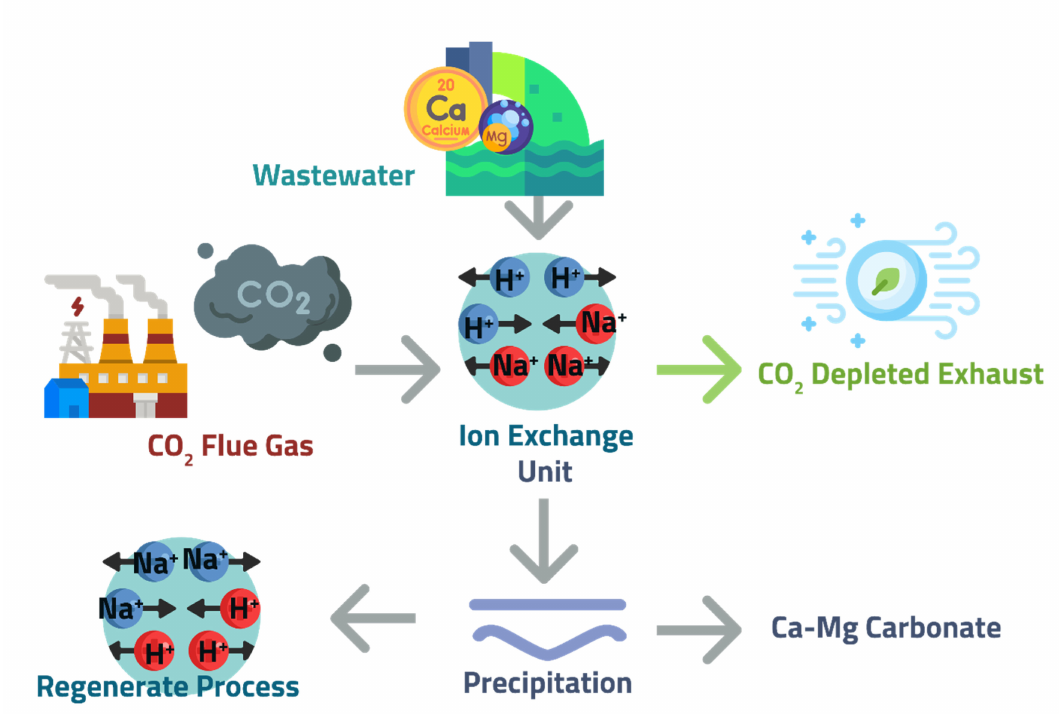
Figure 11. Schematic of the ion exchange